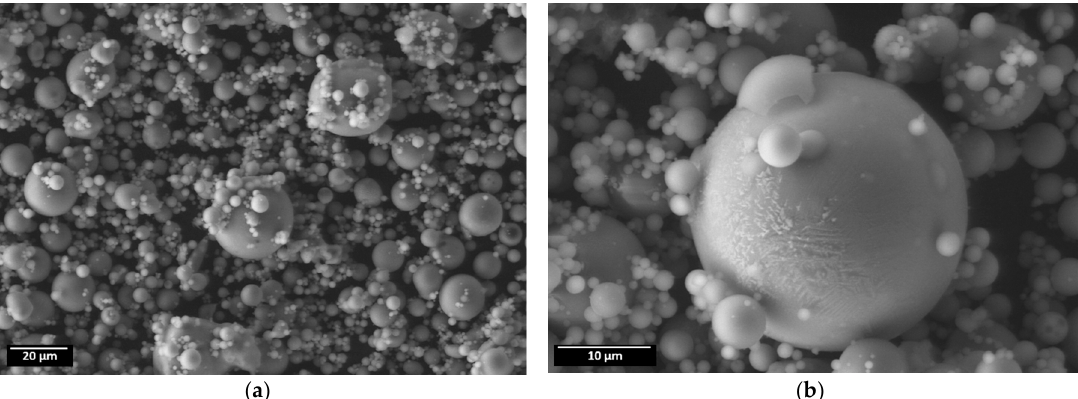
Figure 1. Micrographs of FA powder obtained by scanning electron microscope at lower ( a ) and higher ( b ) magnification. Table 1. Main oxide composition of fly ash (FA) powder.